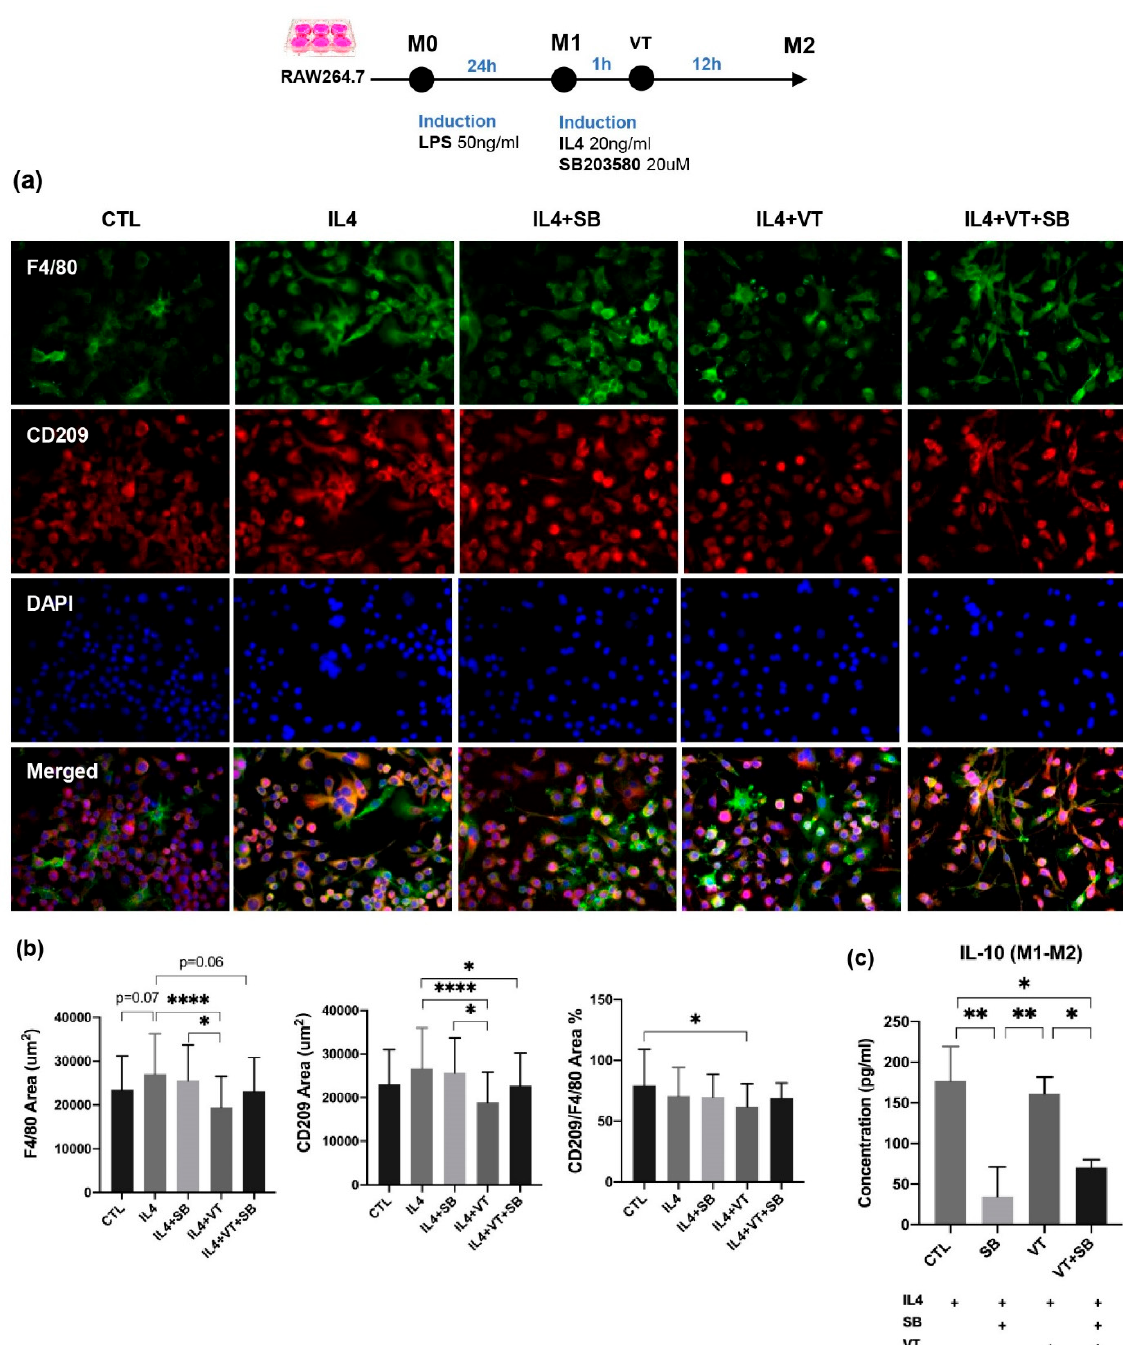
Figure 7. Immunofluorescent staining and inflammatory cytokine levels among different treatment groups for M2 macrophage. ( a ) Immunofluorescence staining of in vitro cultured RAW 264.7 macrophages labeled with F4/80 and CD209 and nuclear counterstaining with DAPI. A morphological transformation of RAW264.7 cells from macrophage-like cells into dendritic-like cells was clearly observed in the CTL group after 24 h incubation with LPS. IL-4-treated RAW264.7 cells acquired larger multi-nuclei, prominent nucleoli, and relatively prominent cytoplasm with increased granularity. Large “spindeloid” macrophages with an elongated cell body and cytoplasmic extensions on the apical ends of the cell bodies and numerous multinucleated giant cells (MNGs) with abundant cytoplasmic projections on the cellular surface were present in the IL-4 group. M2 cells in the IL4+SB group, IL4+VT group, and IL4+VT+SB group underwent migration and adhesion via filopodial projections or fusopods and formed binucleated cells. Intense membranous expression of CD209 antigen by M2-macrophages were observed among all treatments. ( b ) The IL4 group showed a higher trend of F4/80 area compared with the CTL group. The IL4+VT group showed a significantly lower CD209/F4/80 area percentage than the CTL group. The IL4+VT group showed a significantly lower F4/80 area and CD209 area than the IL4 group and IL4+SB